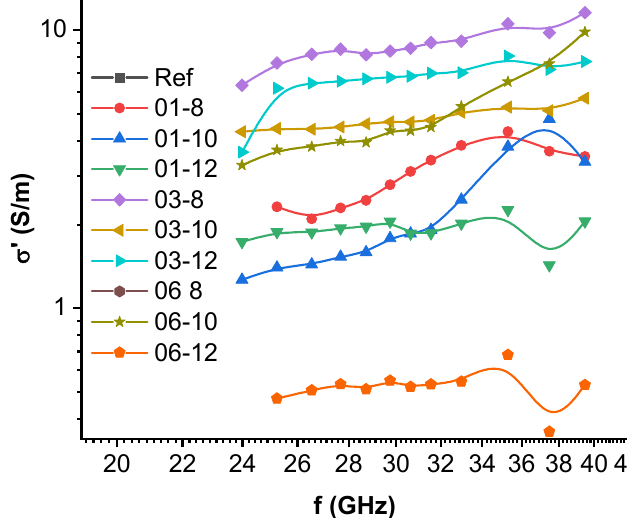
Figure 7. AC conductivity in the microwave K ‐ Ka bands for PBS hybrid nanocomposites.